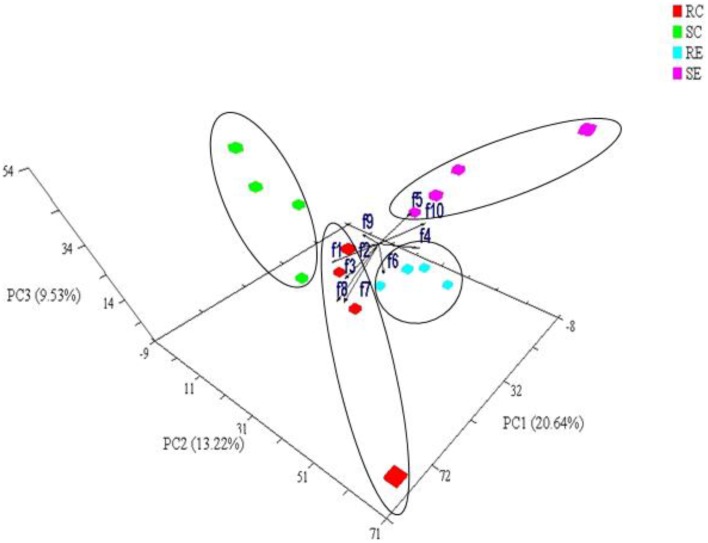
Joint Plot of PCA of Phylum Firmicutes in cecal content. The variance explained by the PCs is indicated in parentheses on the axes. Each symbol represents a single sample. The vector projections showed the relationship between family-level variables in Firmicutes and four treatment groups. The angle and length of the arrows indicated the direction and strength of the relationship. f1, Bacilli Lactobacillales Lactobacillaceae; f2, Bacilli Lactobacillales Streptococcaceae; f3, Unclassified Bacilli; f4, Clostridia Clostridiales Clostridiaceae; f5, Clostridia Clostridiales Lachnospiraceae; f6, Clostridia Clostridiales; f7, Unclassified Clostridia Clostridiales; f8, Unclassified Clostridia; f9, Erysipelotrichi Erysipelotrichales Coprobacillaceae; f10, Erysipelotrichi Erysipelotrichales Erysipelotrichaceae.